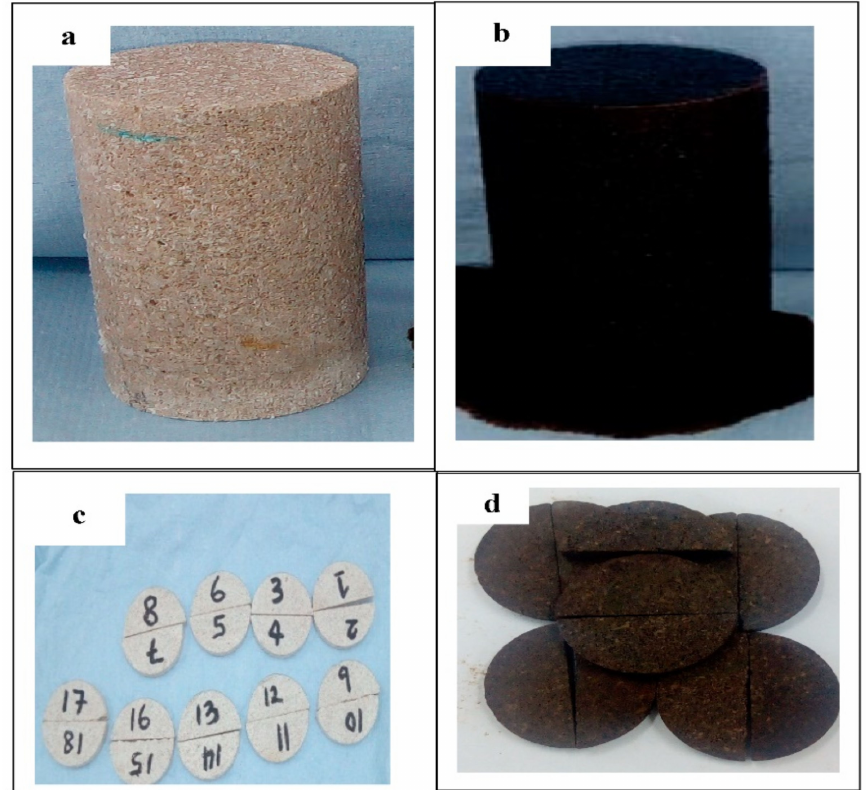
Figure 1. Samples used in the experiments: ( a ) Core plug used in the forced imbibition experi- ment, before aging in oil; ( b ) core plug used in the forced imbibition experiment, after aging in oil; ( c ) pellets used for contact angle measurements, before aging in oil; ( d ) pellets used for contact angle measurements, after aging in oil.